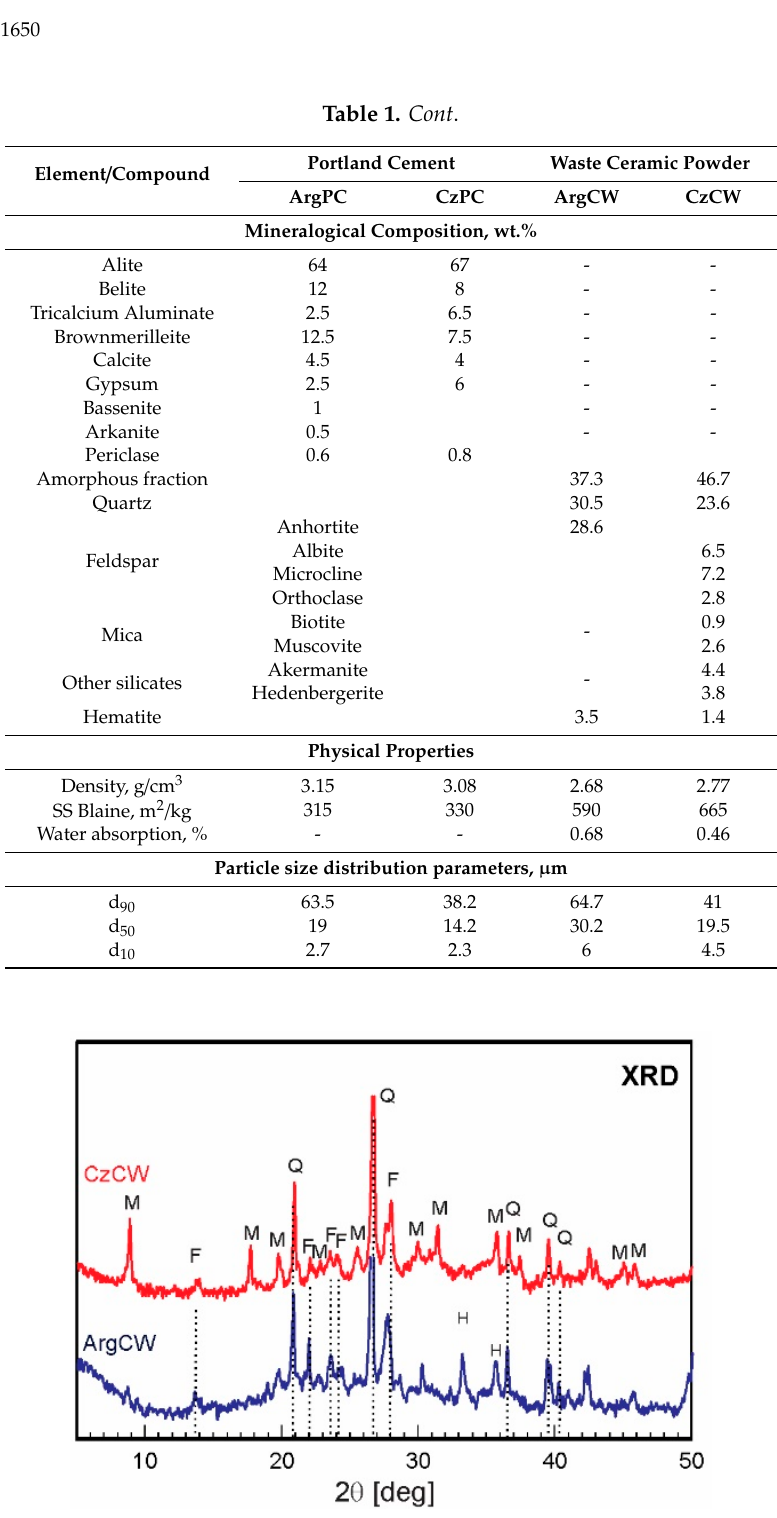
Figure 1. XRD pattern of ceramic waste used (M = muscovite; F = Feldspar; Q = Quartz; H = Hematite).